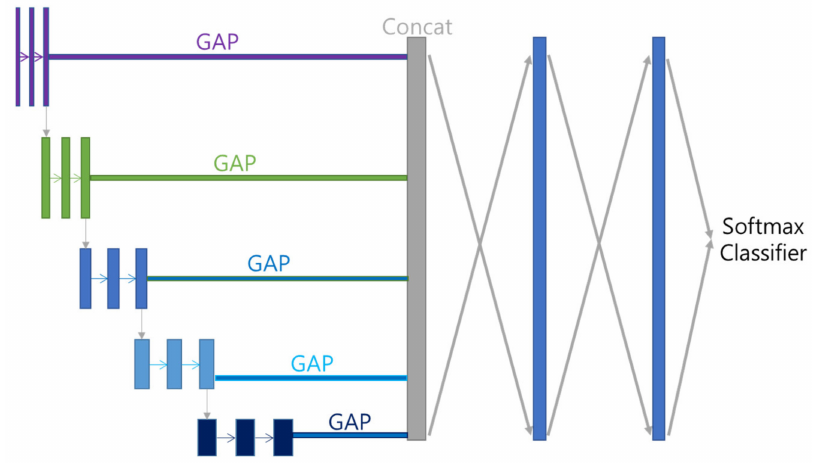
Figure 7. Full model structure.